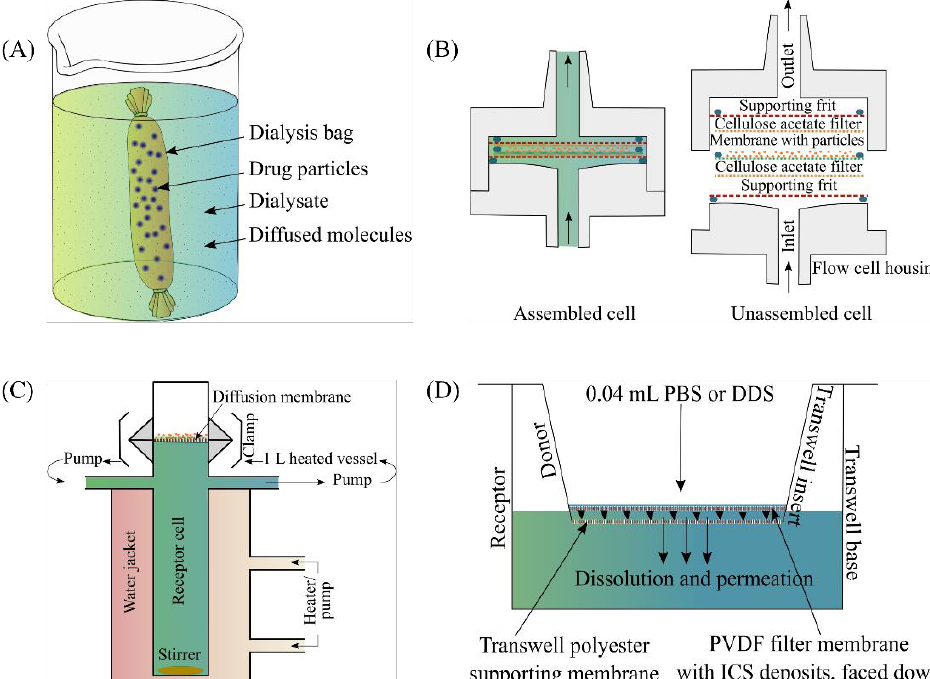
Figure 5. Schematic diagrams of ( A ) dialysis bag method, ( B ) flow-through cell [21], ( C ) Franz diffusion cell [27] and ( D ) Transwell ® system [20].. ( B ) reproduced with permission from Davies and Feddah 2003 [21], Elsevier. ( C ) reproduced with permission from Salama et al., 2008 [27], Elsevier. ( D ) reproduced with permission from Arora et al., 2010 [20], Springer Nature.